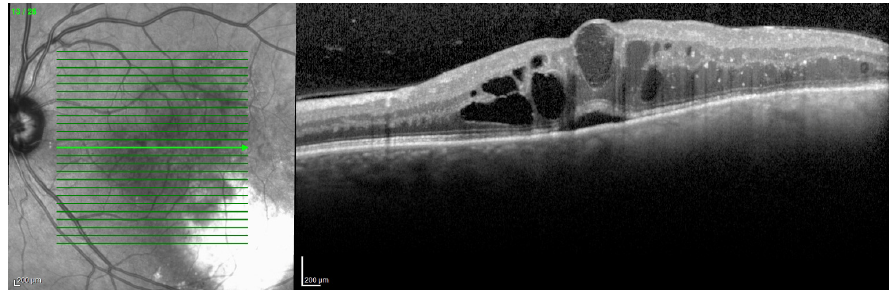
Figure 9. Macular OCT showing cystoid macular edema with limited subfoveal neuroretinal Figure9. Macular OCTshowingcystoid macularedema withlimited subfovealneuroretinal detachment secondary to radiation detachment secondary to radiation maculopathy.